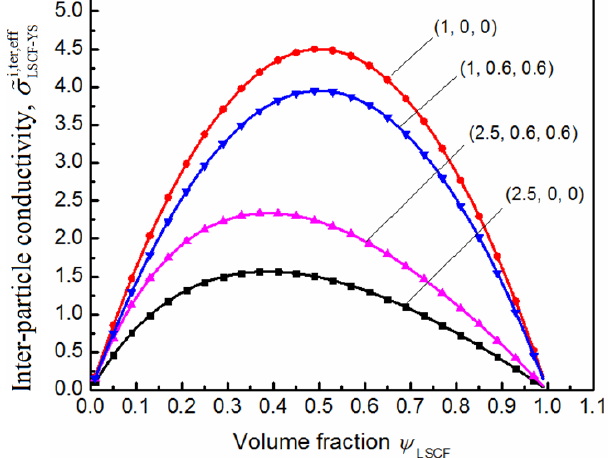
Figure 11. Dependence of the effective non-dimensional inter-particle ionic conductivity